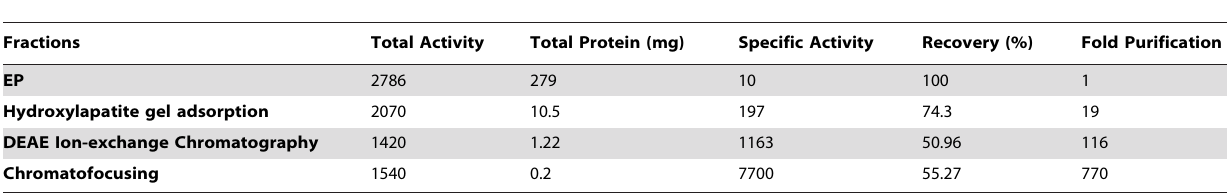
Table 1. Purification of MIF-II from caprine epididymal plasma.